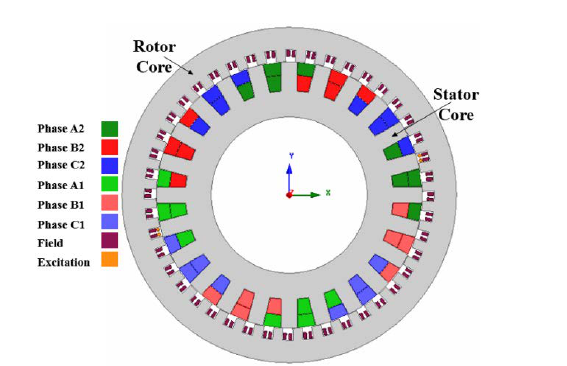
Figure 3. Machine Layout with stator and rotor winding configuration.